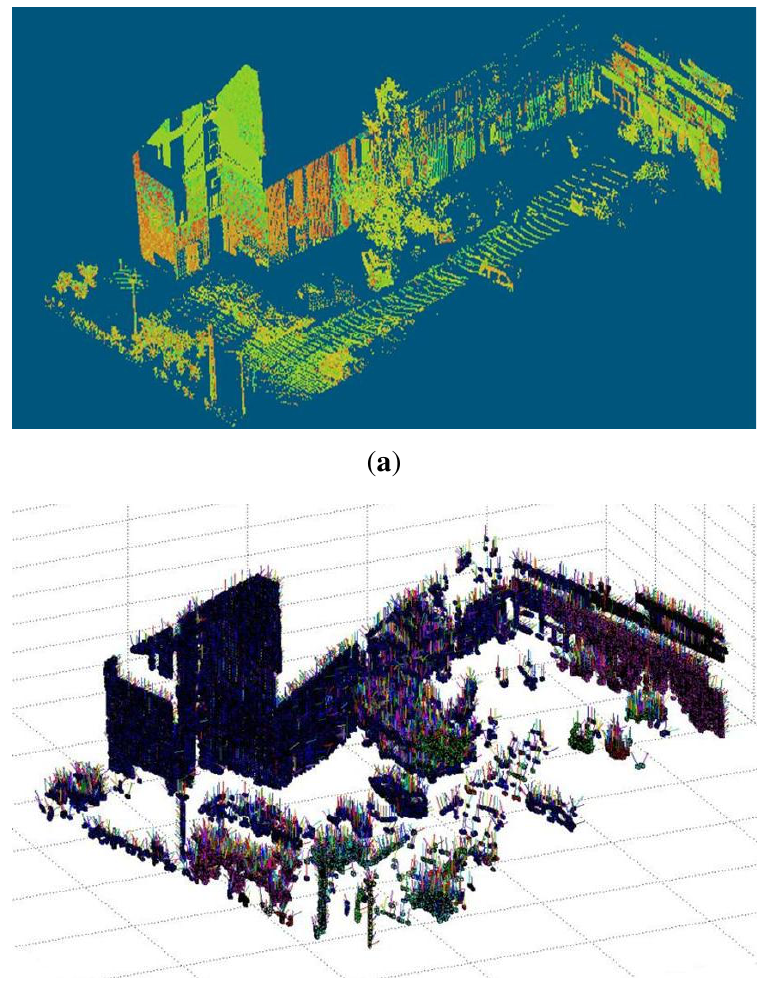
Figure 8. (a) 3D data points—shows 3D data points of data set 3. (b) Voxelisation and segmentation into objects—shows s -voxel segmentation of 3D points (along with orientation of normals). (c) Labeled points—shows classification results (labeled 3D